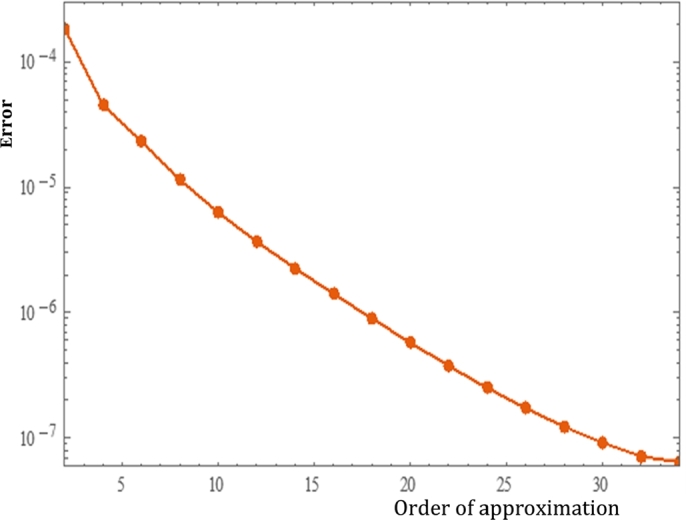
Total squared residual error.